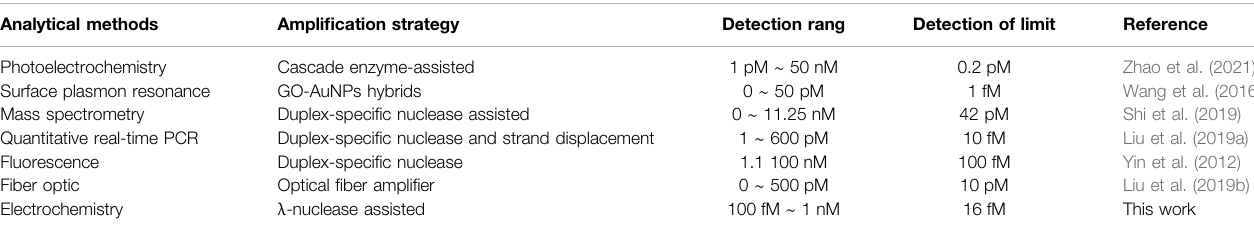
TABLE 2 | Comparison of this biosensor and other reported methods for miRNA141 detection based on different signal ampli fi cation strategies. Analytical